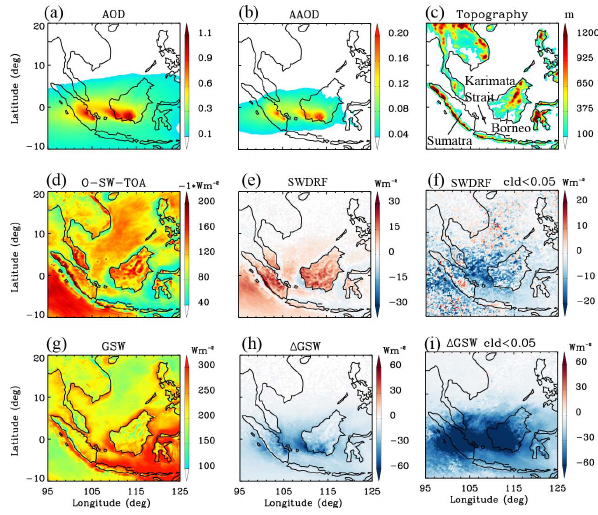
Fig. 1. Distribution of monthly averaged variables in October 2006. (a) aerosol optical depth (AOD) in 600nm, (b) aerosol absorption optical depth (AAOD) in 600nm, (c) topography in meters, (d) out- going shortwave (SW) at top of amosphere (TOA), O-SW-TOA, (e) aerosol shortwave direct radiative forcing (SWDRF) at TOA, (f) aerosols SWDRF at TOA for column cloud fraction less than 0.05, (g) net shortwave flux at the ground (GSW), (h) difference of GSW ( 1 GSW), (i) 1 GSW for column cloud fraction less than 0.05. The difference of each variable ( 1V ) is defined as 1V = V Ra − V non-Ra . The OC/BC ratio is 10 in the